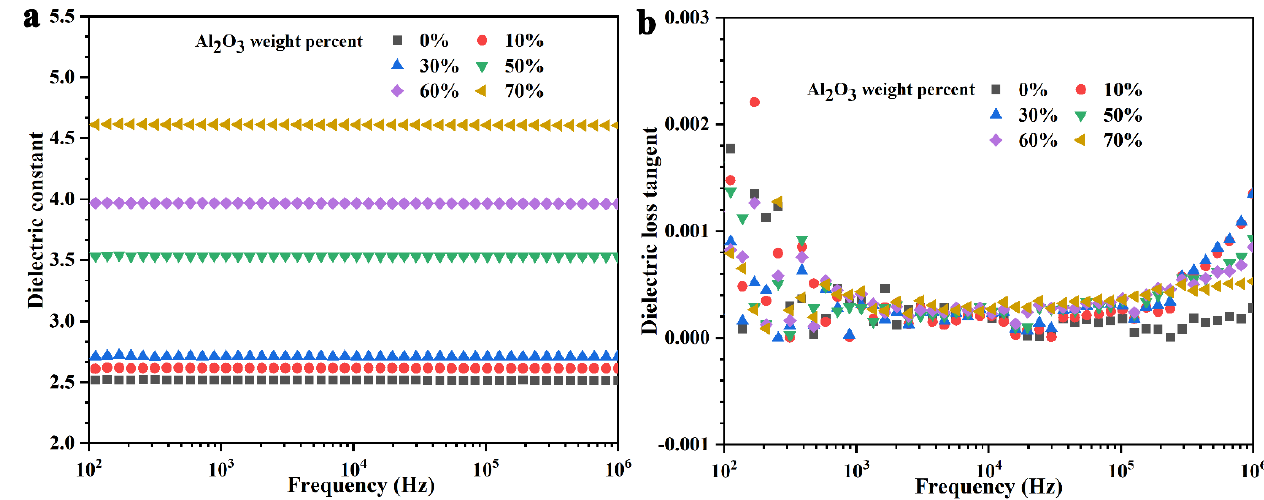
Figure 7. ( a ) Dielectric constant and ( b ) dielectric loss of the neat SR and B-Al 2 O 3 /SR composites.